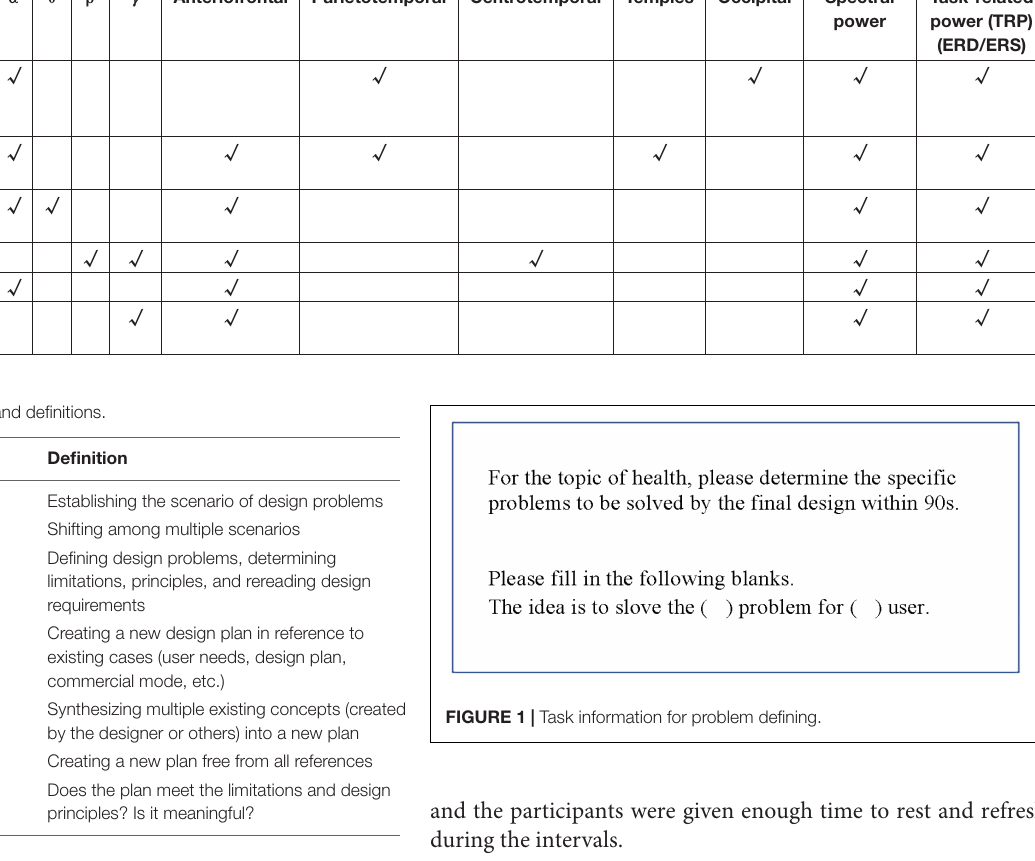
TABLE 1 | Comprehensive analysis of elements of thinking and EEG (frequency band, brain area, and traits). (cid:72) (cid:72) (cid:72) (cid:72) (cid:72) (cid:72) (cid:72) (cid:72)(cid:72) Thinking